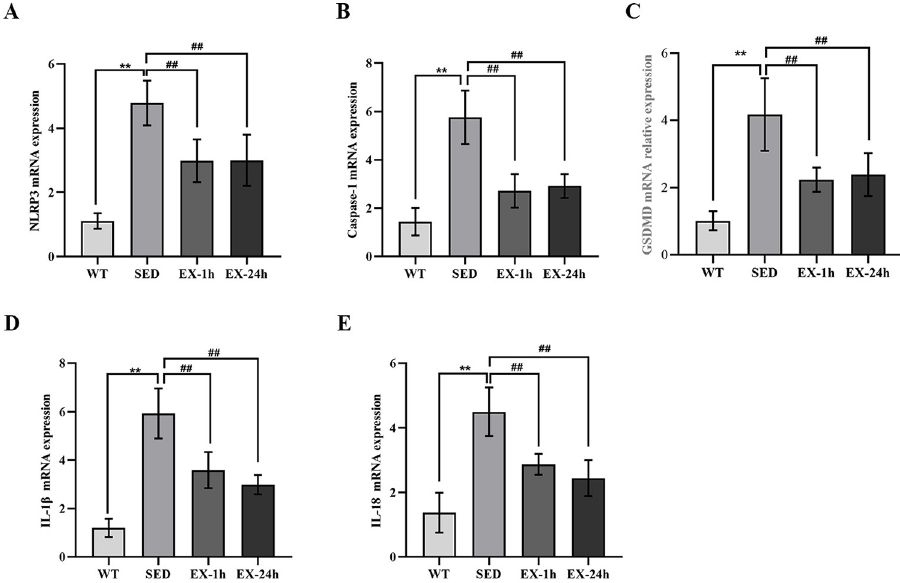
Fig 7. Aerobic exercise inhibits NLRP3 inflammasome-mediated pyroptosis-related factor mRNA expression in the aorta. ( A - E ) The mRNA expression of NLRP3, caspase-1, GSDMD, IL-1 β , and IL-18 in the aorta were detected by real-time polymerase chain reaction (n = 7). Data are presented as mean ± SD of three experiments, �� p < 0.01 vs. WT group; ## p < 0.01 vs. SED group.